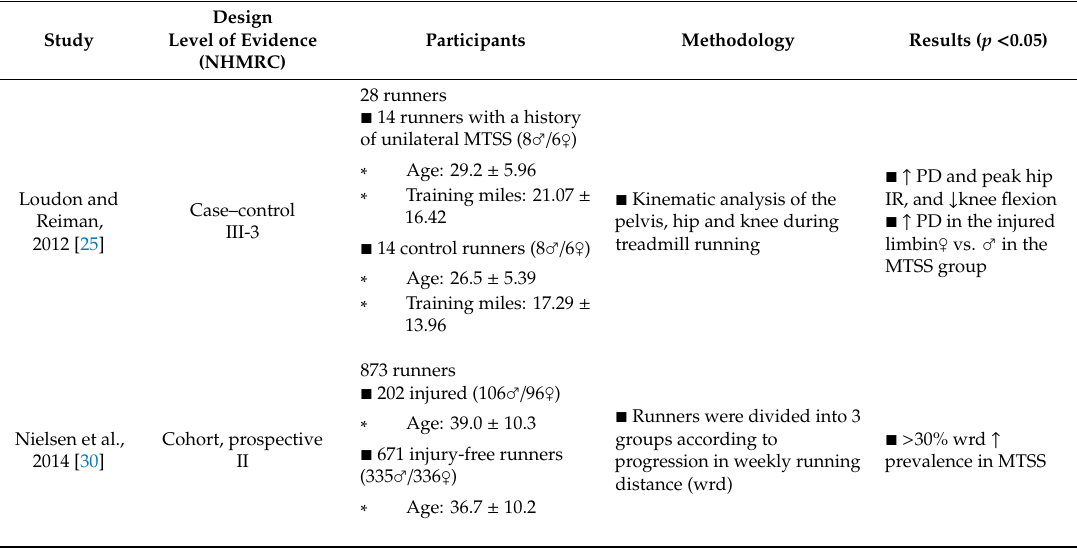
Table 3. Summary of studies analyzing etiological